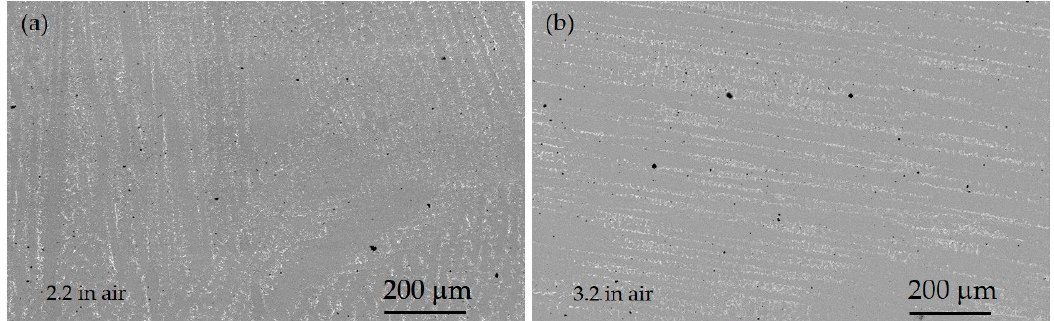
Figure 10. CBS-SEM images of Hastelloy C-22 specimen manufactured in air with thermal treatment, ( a ) thermal treatment 1 (TT1) (rapid air cooling (RAC)) and ( b ) TT2 water quenching (WQ).